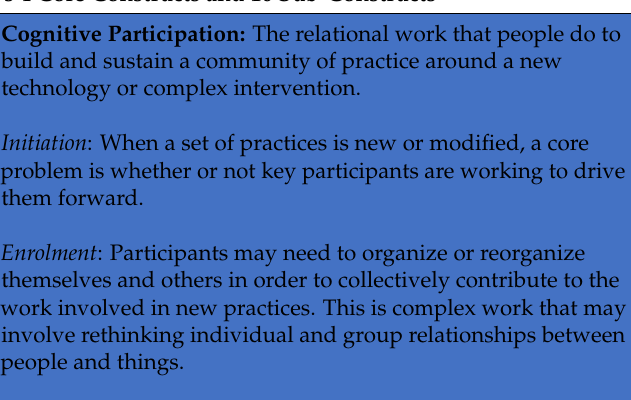
Table A1. Description of the constructs in the normalization process theory. All content is from normalization process theory toolkit (http://www.normalizationprocess.org/what-is-npt/npt-core- constructs/) accessed on 27 October